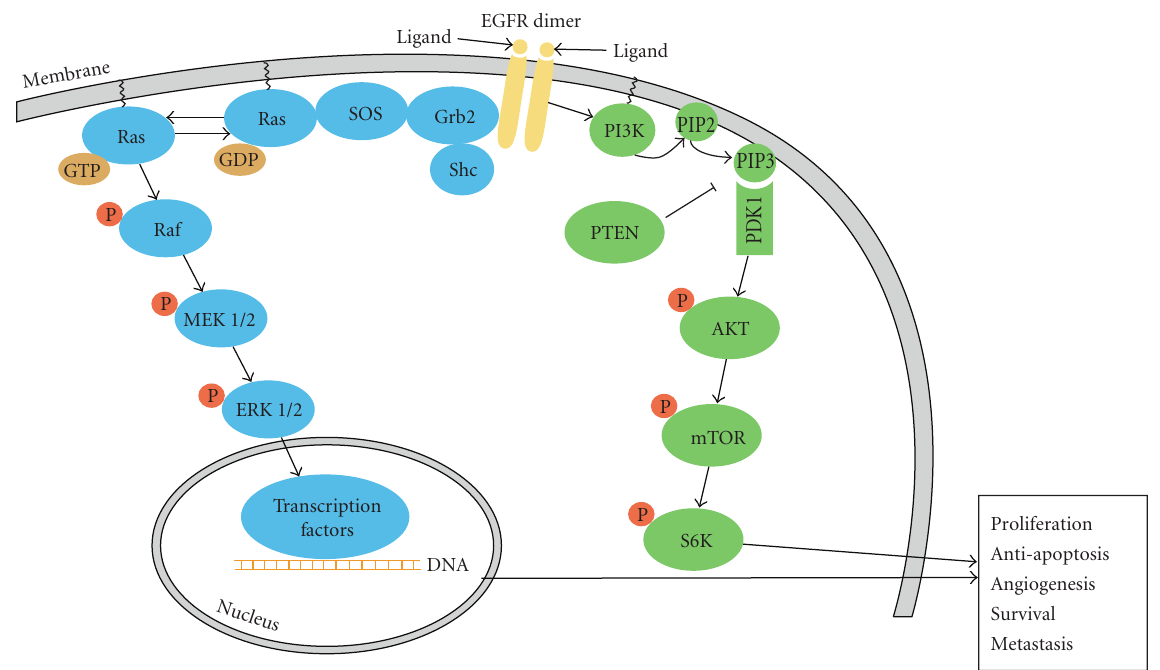
Figure 1: Signaling pathway of the KRAS protein. Following EGF binding to its receptor and activation of tyrosine kinases, the KRAS protein becomes activated by binding to GTP, transducing the activation signal to the nucleus by MAPKs and PI3K/AKT-mediated cascades. Specifically, the active state of the KRAS protein is facilitated by binding to the Grb2 protein, which interacts with the SH3 domains of the SOS protein, a member of the nucleotide exchange factor family. In the GTP state, KRAS is able to activate downstream proteins and to regulate cell transformation.